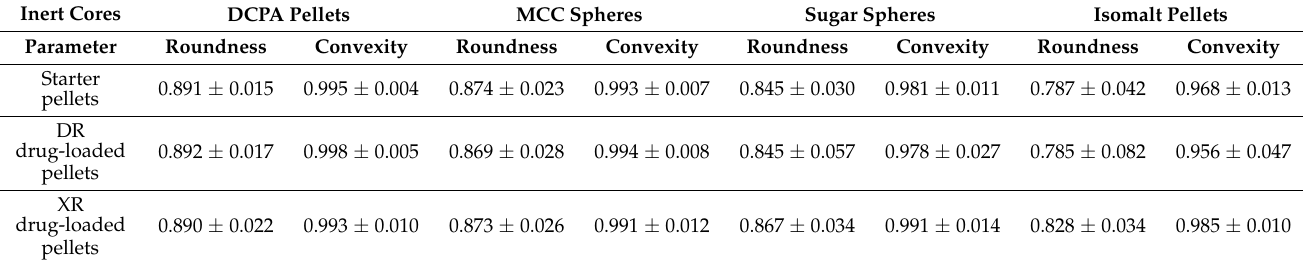
Table 3. Comparison of the roundness and convexity of starter and drug-loaded pellets.